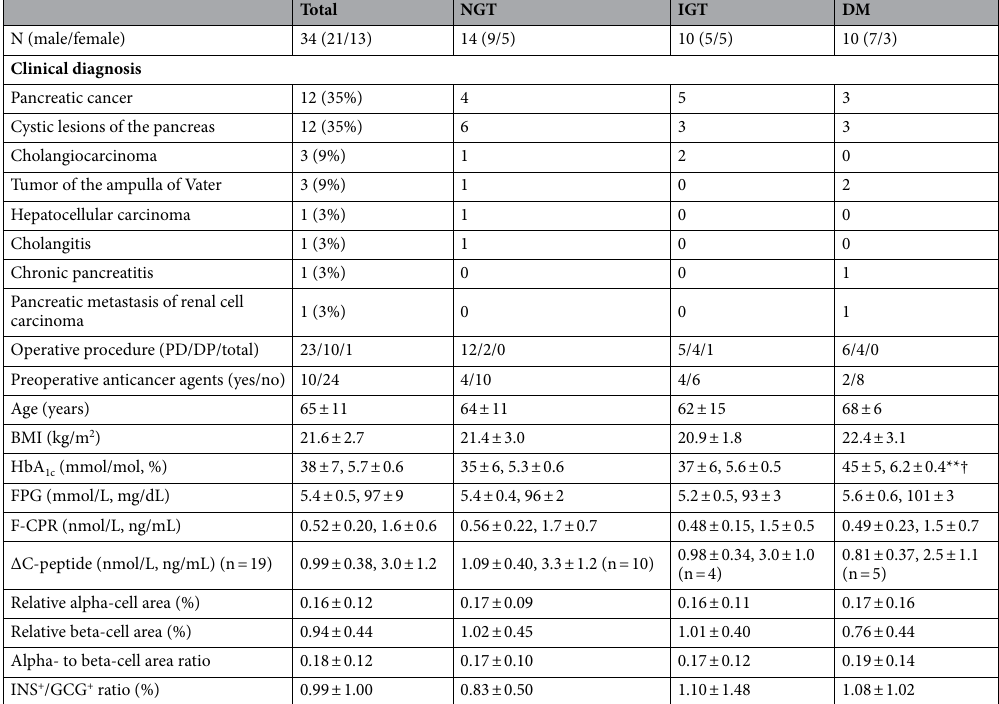
Table 1. Patient clinical characteristics and data. NGT normal glucose tolerance, IGT impaired glucose tolerance, DM diabetes mellitus, PD pancreaticoduodenectomy, DP distal pancreatectomy, FPG fasting plasma